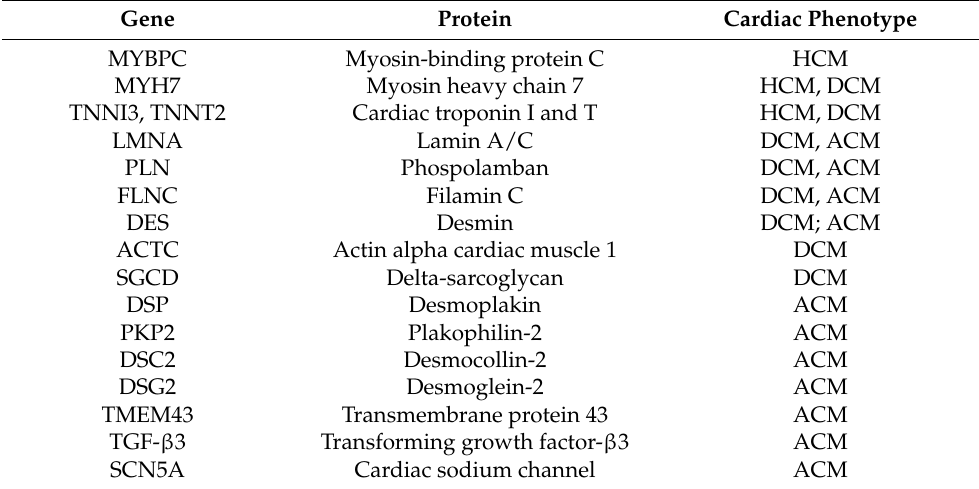
Table 1. Summary of the main causative genetic mutations involved in the pathogenesis of HCM, DCM, and